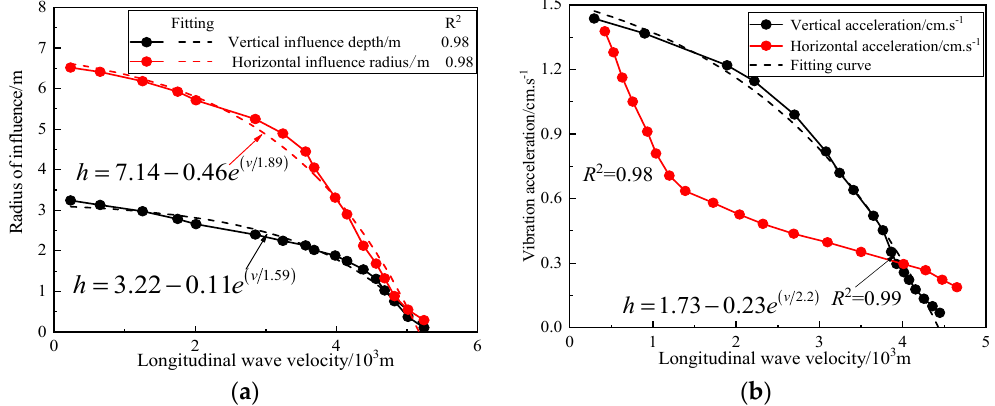
Figure 21. Comparison of longitudinal wave velocity before and after blasting. ( a ) Radius of influence; ( b ) Vibration